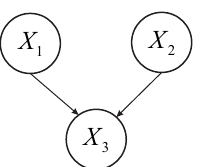
Figure 4. Example three-variable Bayesian network, where X 1 and X 2 are the independent parents of X 3